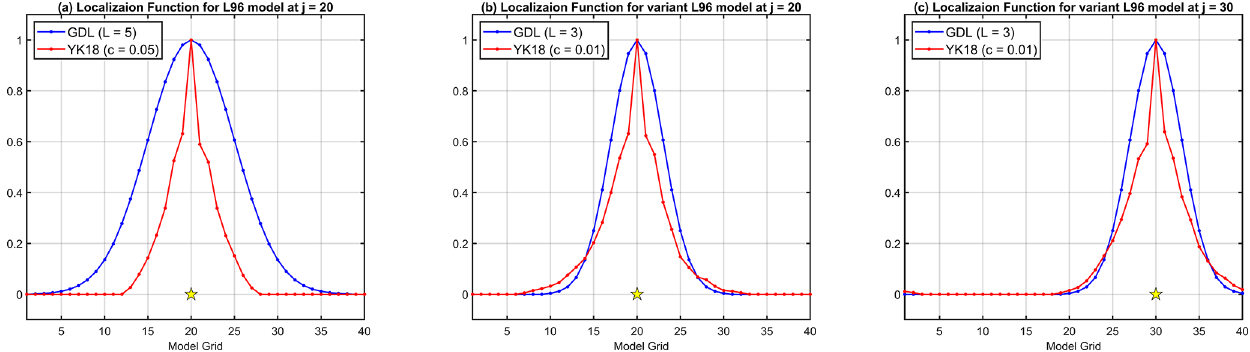
Figure 3. The localization functions of GDL (blue) and YK18 (red) for (a) the L96 model and (b, c) the variant L96 model but for the different observation sites. The yellow stars represent the corresponding observation sites. The results presented here are for the case of 10 ensembles and 40